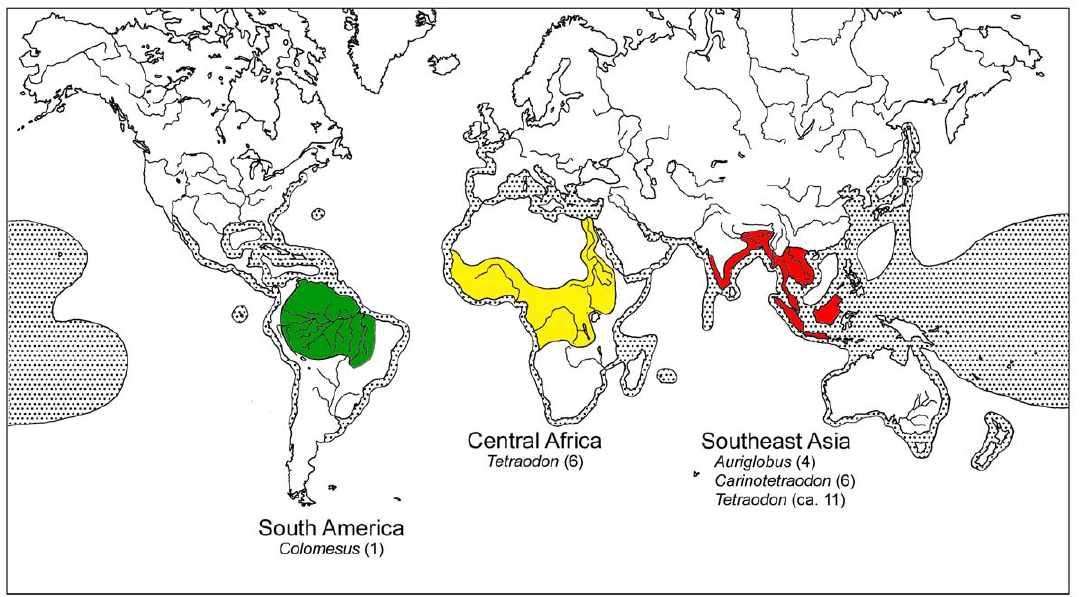
Figure 1. Distribution patterns of marine (shaded) and freshwater (colored) species in Tetraodontidae. Freshwater genera in South America, Central Africa, and Southeast Asia are shown with numbers of species in parentheses. Freshwater regions where only diadromous species occur are not indicated here. Distribution data follow Berra [11], Ebert [18], and Froese and Pauly [12].